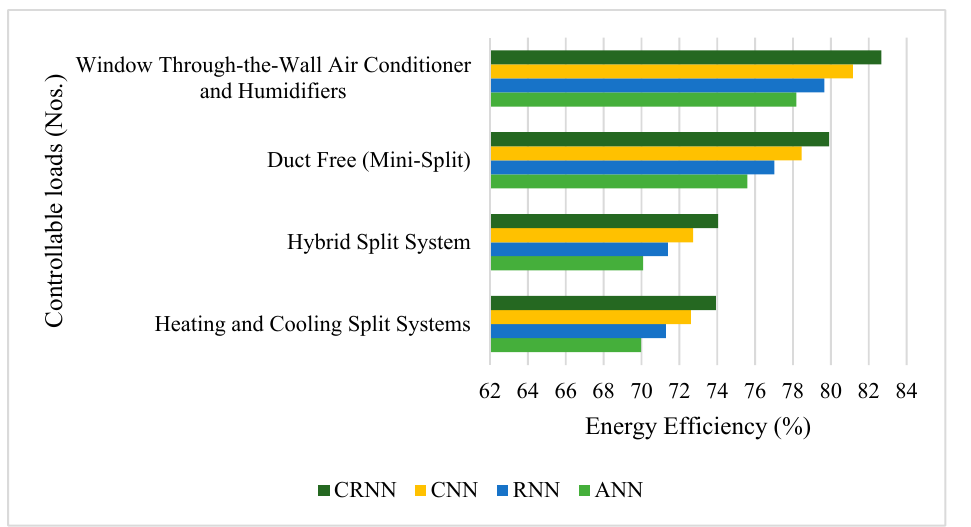
Figure 10. Energy efficiency (%) over various deep learning algorithms with controllable loads.